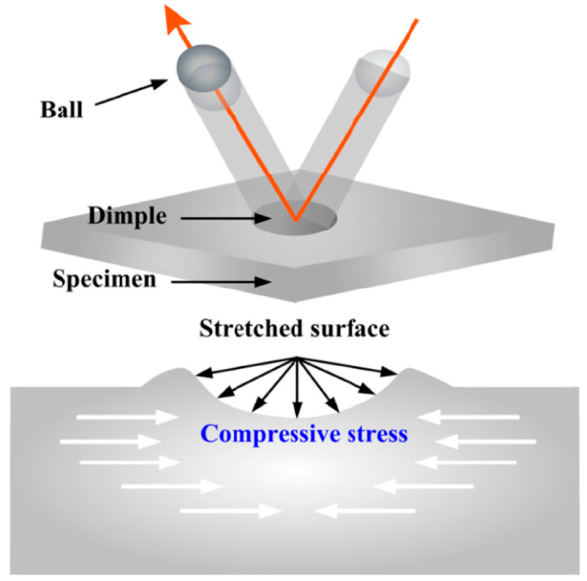
Figure 10. SPF principle of metallic sheets (reprinted with permission from [136]; copyright© 2021, Springer-Verlag London Ltd., part of Springer Nature).